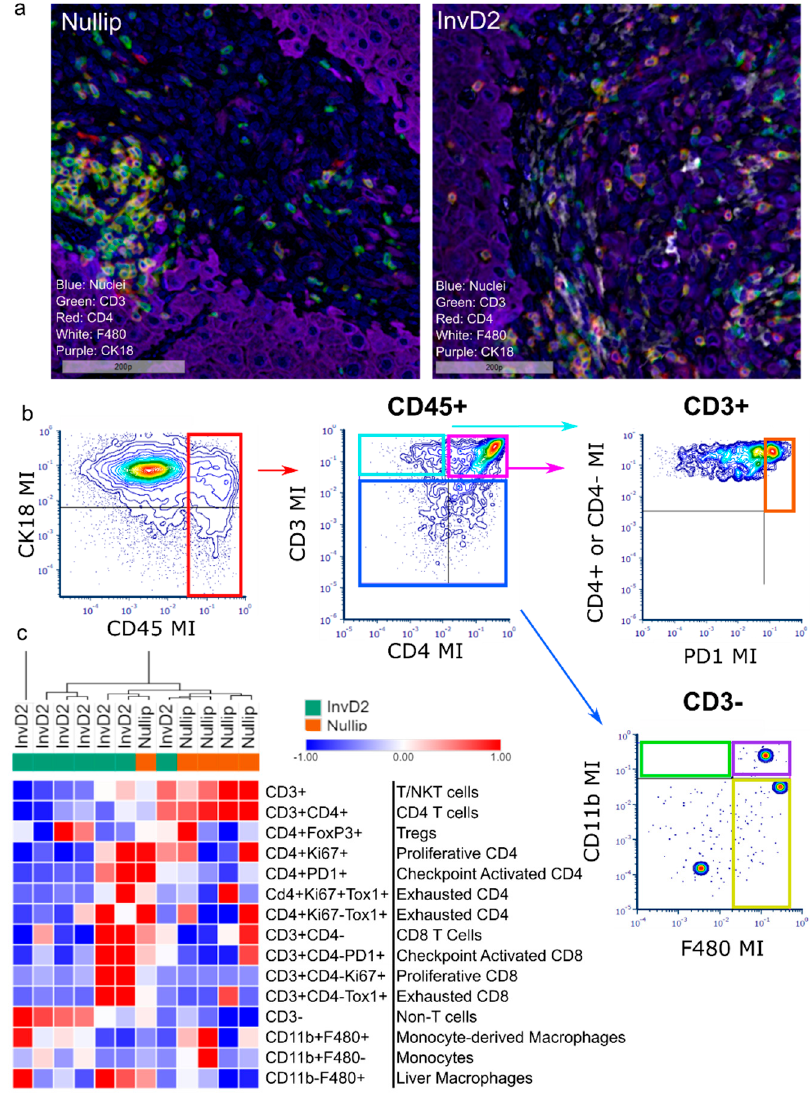
Figure 4. Immune milieu of liver metastases differs by host reproductive state. ( a ) Representative pseudo-colored multiplex IHC images of liver metastases in nullip and InvD2 mice euthanized 14 days after intraportal tumor cell injection showing select biomarkers: nuclei (blue), CD3 (green), CD4 (red), F480 (white), and CK18 (purple); ( b ) Representative image cytometry gating schema, showing the identification of CD45+, CD3+/ − , CD4+/ − , and PD1+ populations; ( c ) Hierarchical-clustered heat-map of intra-tumoral immune cell populations (%CD45+) identified by image cytometry of multiplex IHC staining for 9 biomarkers (CD45, CD3, CD4, FoxP3, Ki67, PD1, Tox1, CD11b, and F480). Tumor data are reported as average per mouse.